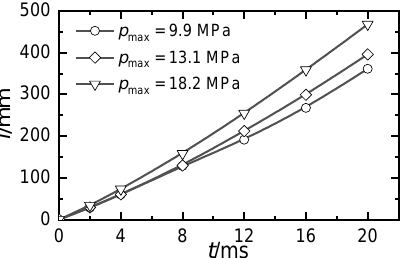
Figure 7. Gas-curtain displacement under different maximum pressures.